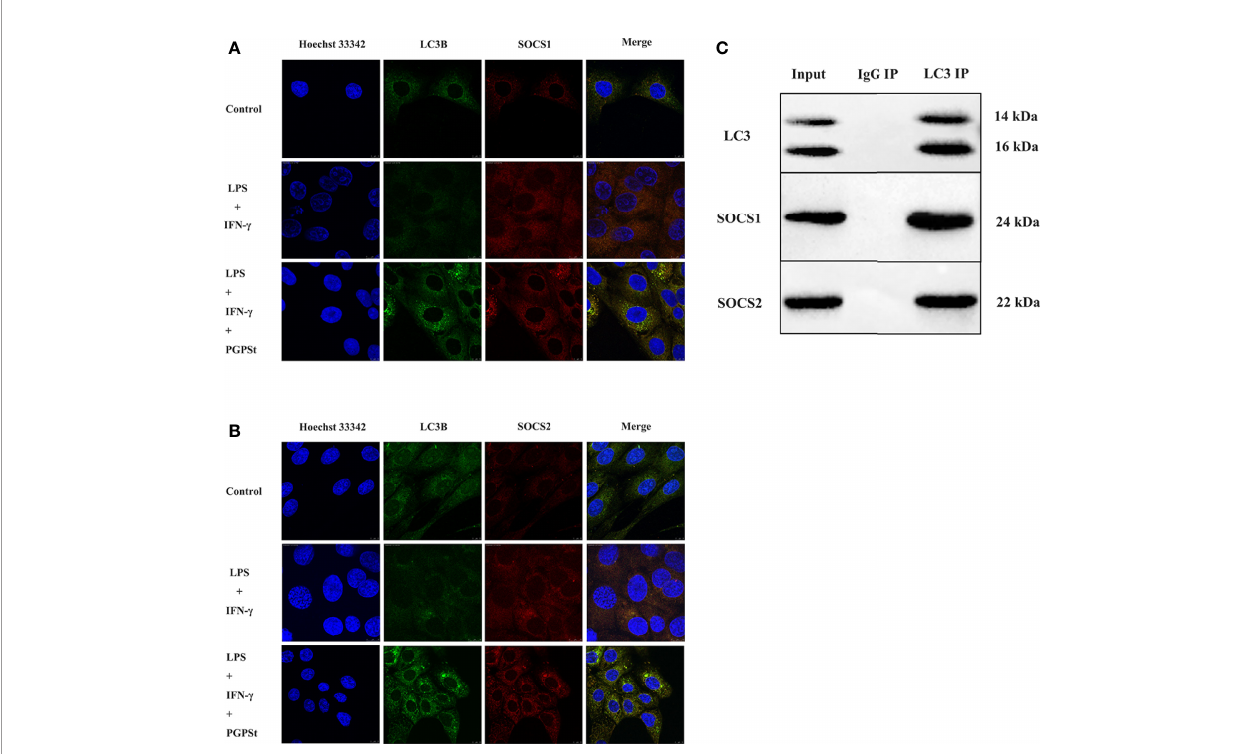
FIGURE 6 | The confocal and co-IP con fi rmed the co-localization between LC3 and SOCS1, LC3, and SOCS2 in 3D4/21 cells. (A) Co-location of SOCS1 and LC3. (B) Co-location of SOCS2 and LC3. (C) Protein interactions between SOCS1 and LC3, SOCS2, and